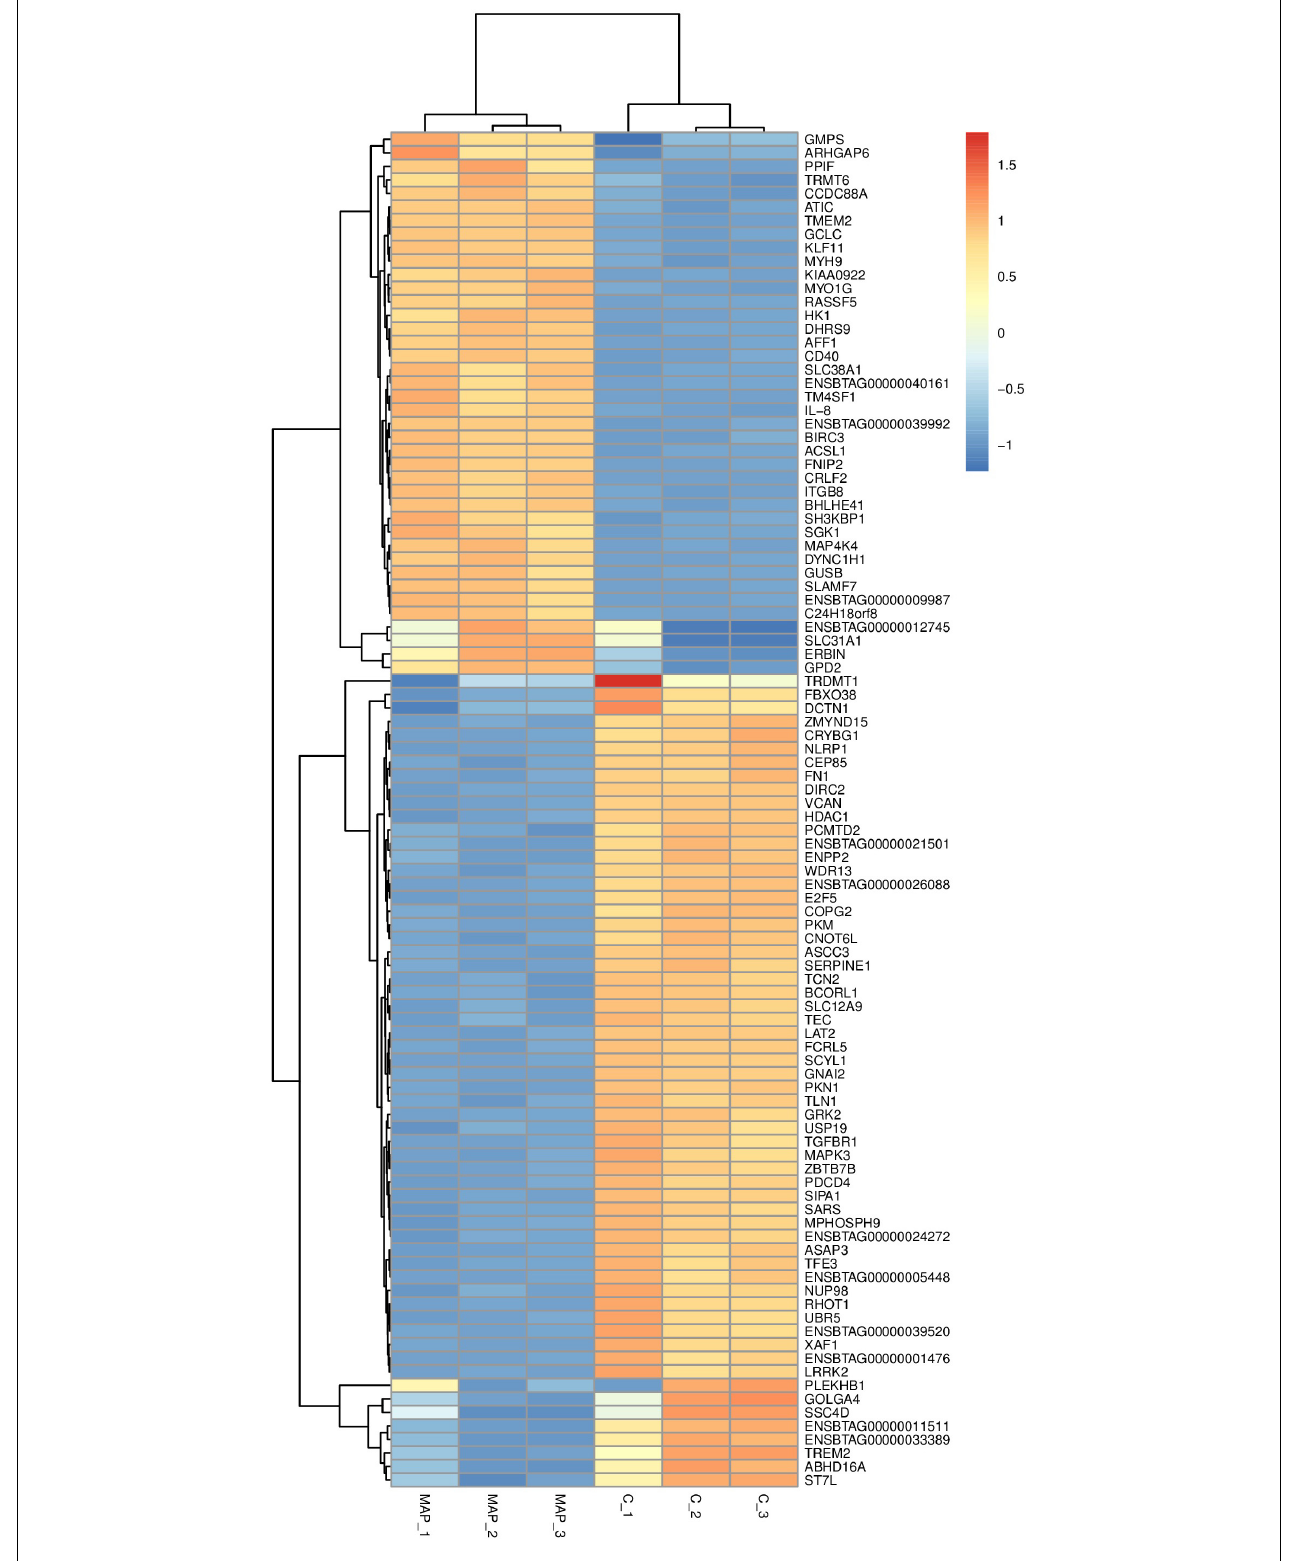
FIGURE 5 | Cluster analysis of differential gene expression level. The abscissa is the sample and the ordinate is the gene. Red indicates high expression gene, and dark blue indicates low expression gene.